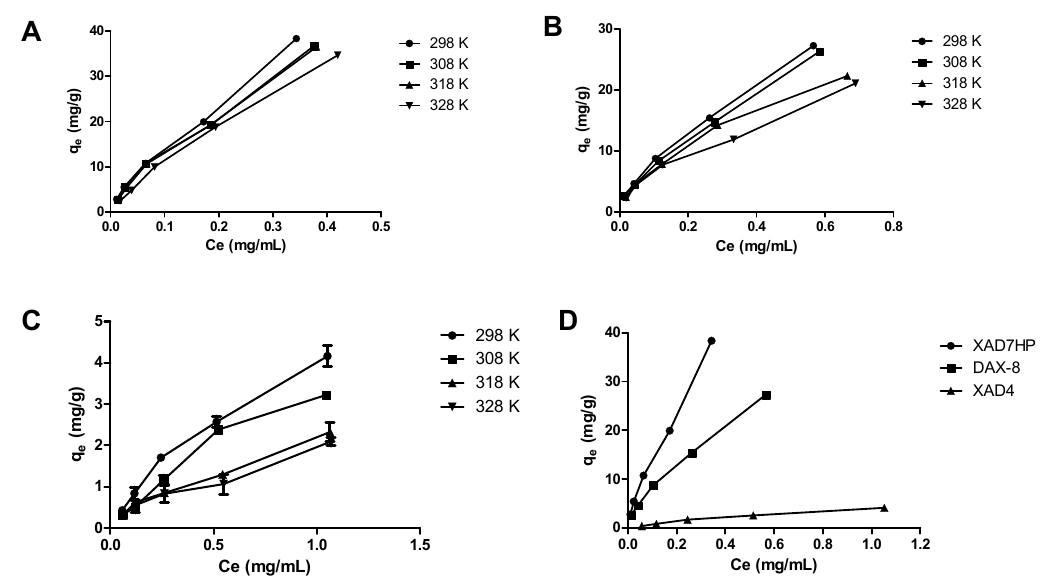
Figure 3. Adsorption isotherms curves of OPL total flavonoids on ( A ) XAD7HP, ( B ) DAX-8, and ( C ) XAD4 at different temperatures; ( D ) comparison of adsorption isotherms of the selected MARs at 298 K.